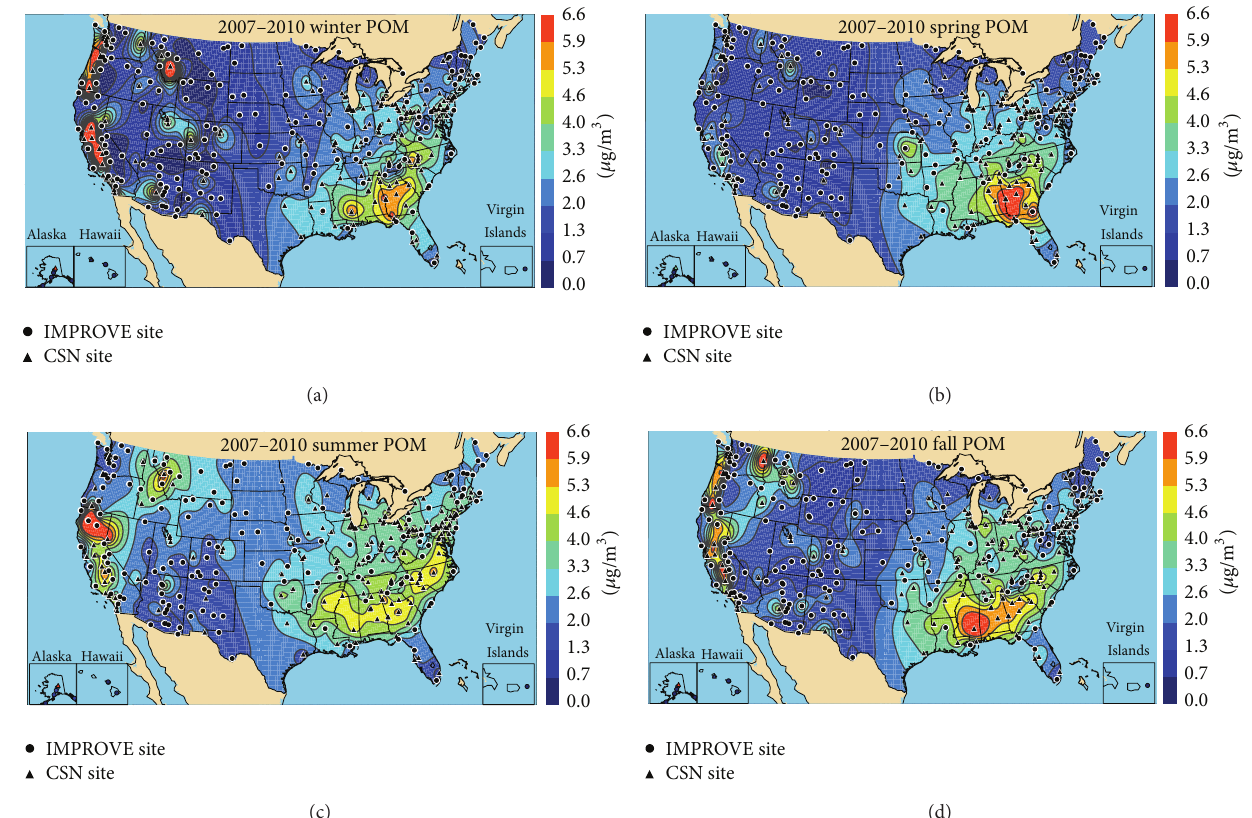
Figure 1: IMPROVE and CSN 2007–2010 seasonal mean PM 2.5 particulate organic matter (POM) ( 𝜇 gm −3 ) for (a) winter (DJF), (b) spring (MAM), (c) summer (JJA), and (d) fall (SON). IMPROVE sites are shown as circles, and CSN sites are shown as